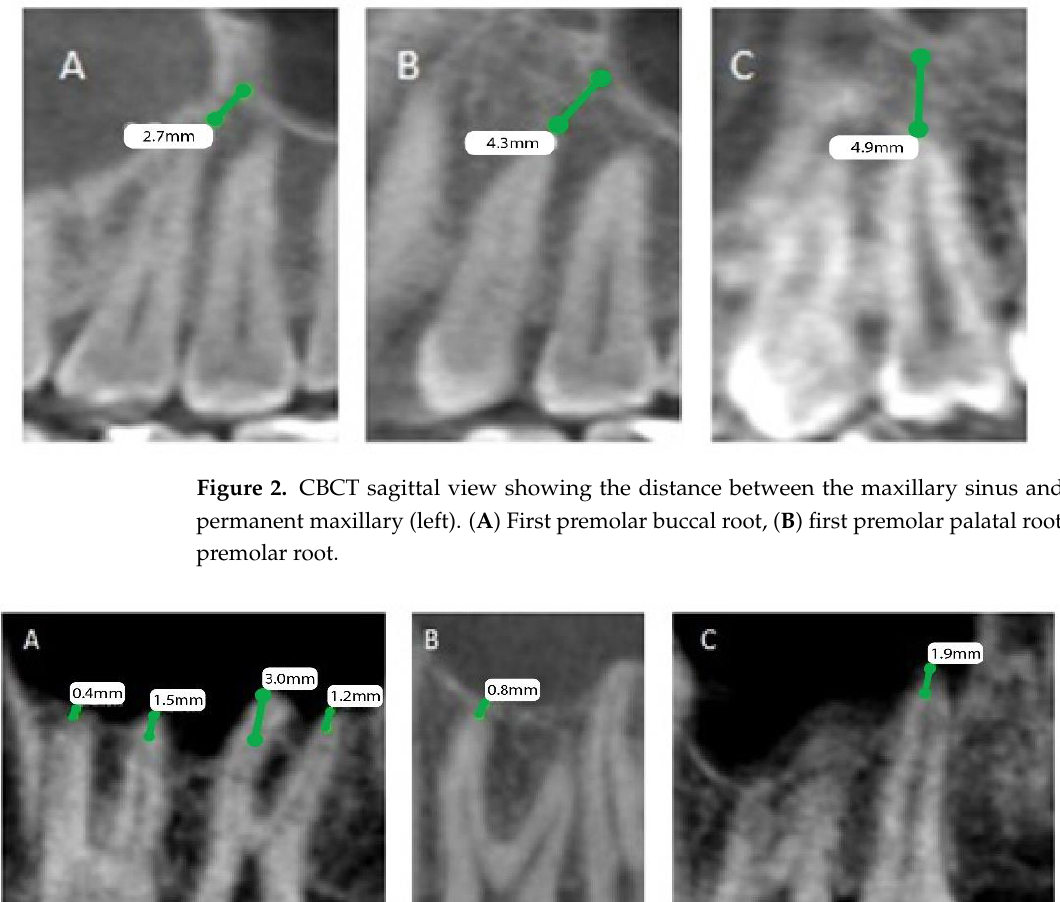
Figure 1. CBCT sagittal view showing the distance between the maxillary sinus and the root of per- manent maxillary (right). ( A ) First premolar buccal root, ( B ) first premolar palatal root, ( C ) second premolar root.